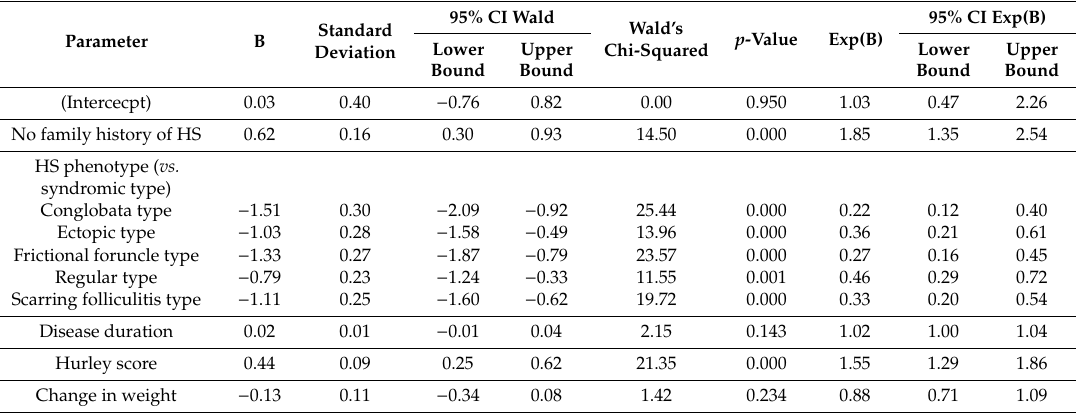
Table 2. Multivariate log-linear robust Poisson regression analysis shedding light on the determinants of change in nodules before, during and after the month of